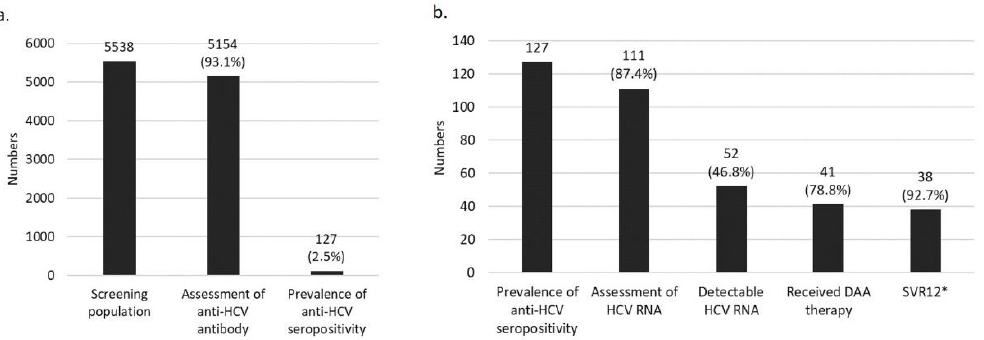
Figure 3. HCV care cascade. ( a ) Number and rate of anti-HCV antibody assessments. ( b ) Number and rate of HCV RNA detection, treatment and SVR12. * ITT-SVR was 92.7% and PP-SVR was 100%. The SVR data were unavailable in three patients until May 2021.